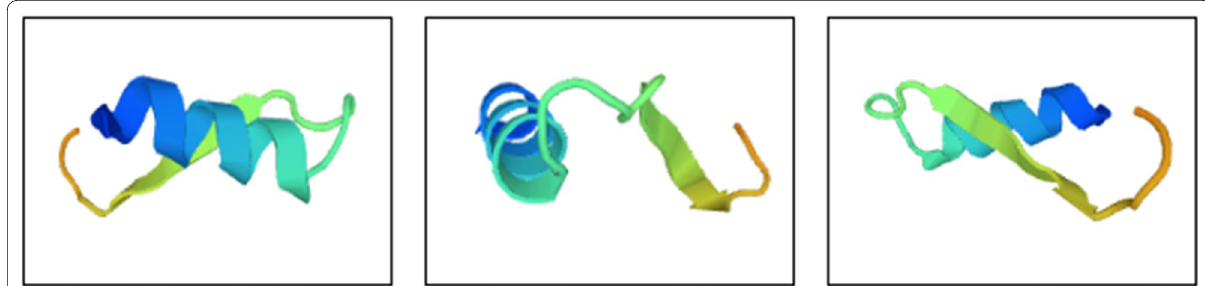
Fig. 2 SWISS-MODEL prediction tertiary